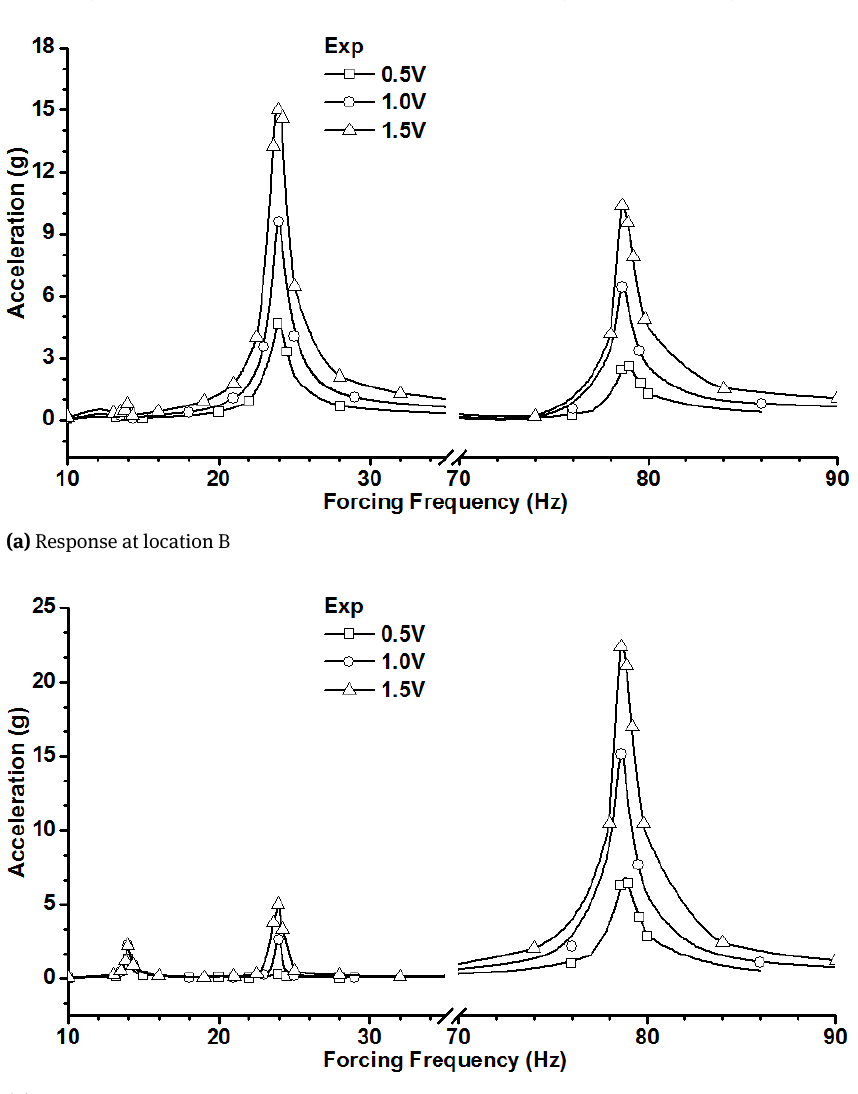
Figure 8: Acceleration versus forcing frequency curves of curved beam (span angle = 130 ∘ ) excited at location B with excitation amplitudes of 0.5, 1.0 and 1.5 volts: (a) Response at B, (b) Response at